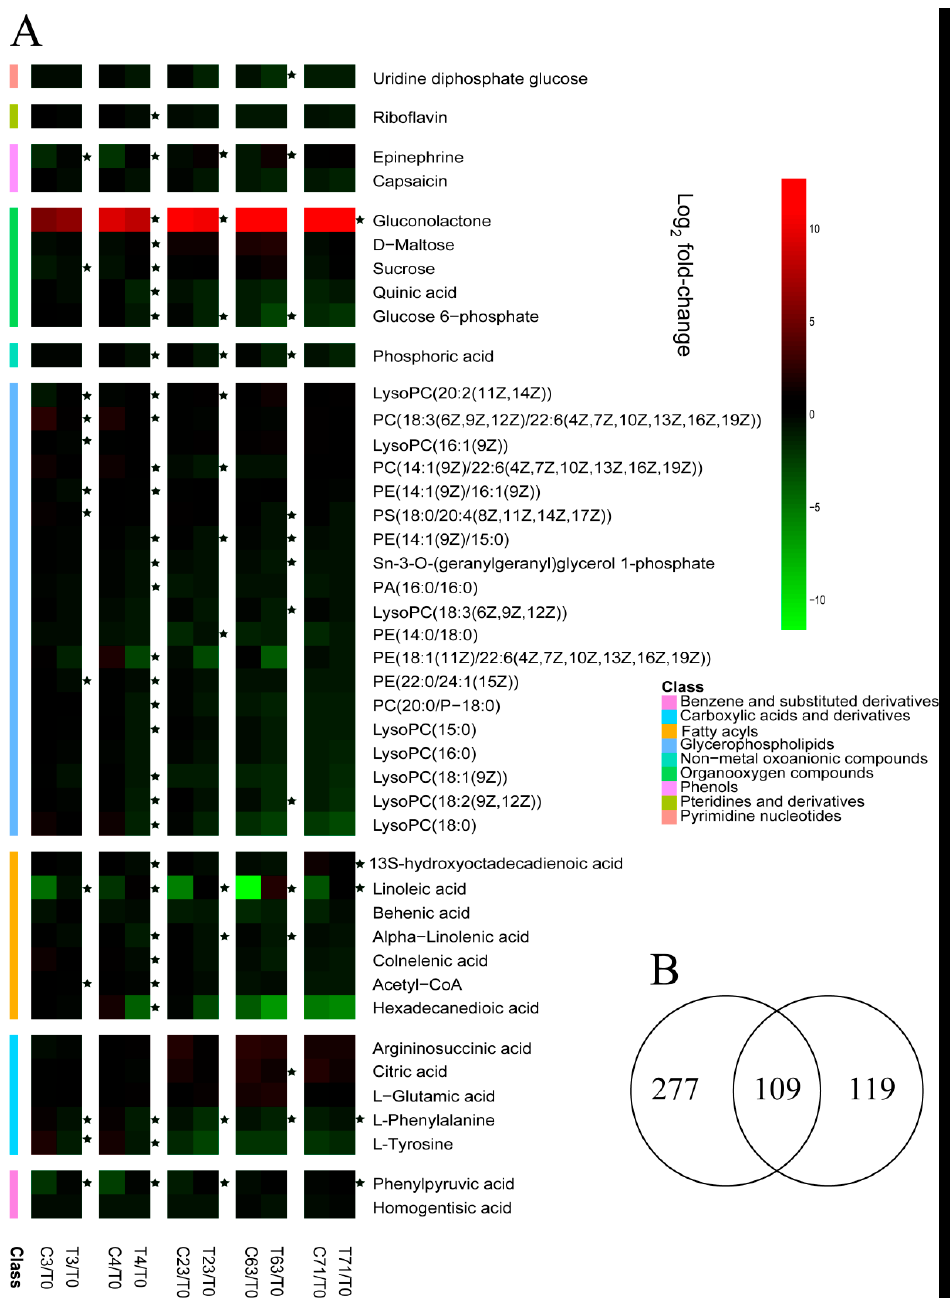
Figure 5. Metabolites accounting for flowering in Guiwei litchi leaves from terminal flush at the turning stage were screened. ( A ): Heat map of fold-changes relative to 0 day for metabolites accounting for flowering in Guiwei litchi leaves from terminal flushes. C indicates samples of trees from the control group. T indicates samples of trees from the girdled group. The numbers 0, 3, 4, 23, 63, and 71 indicate the sampling time. Values represent the means of log2-transformed fold-changes from six biological replicates relative to the T0 (before treatment). Asterisks (*) indicate significant differences between treatments determined by an unpaired t-test at p < 0.05. ( B ): Venny diagram of group comparison for metabolic profiles for flowering in the control group and the girdled group. C3 vs. C63 indicates different metabolites in Guiwei litchi leaves in the control group during floral induction. T3 vs. T63 indicates different metabolites in Guiwei litchi leaves in the girdled group during floral induction. A total of 505 metabolites were identified in this study and the numbers in the figures indicate the numbers of different metabolites for each comparison.